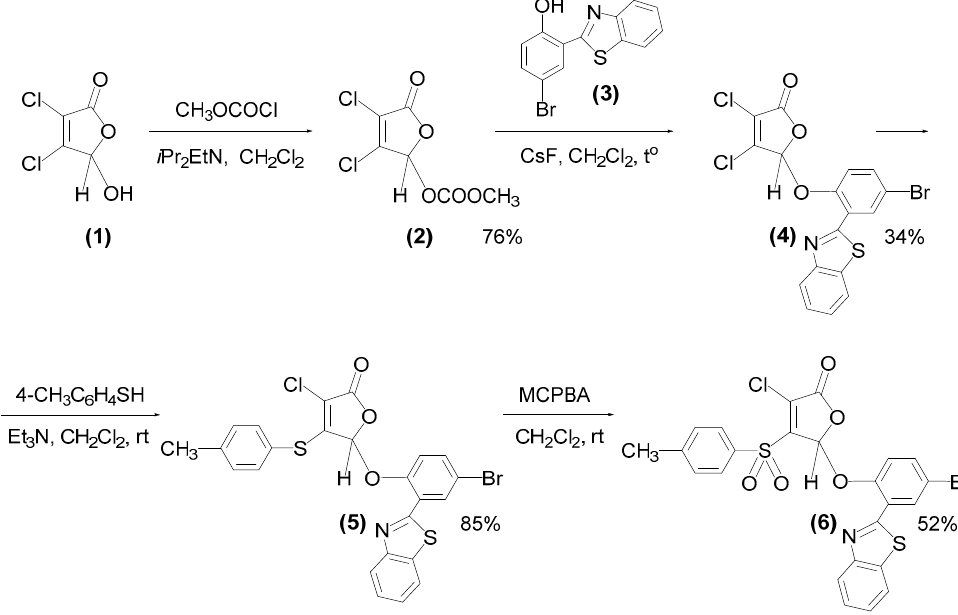
Figure 1. Synthesis of a fluorescent derivative of 2(5 H )-furanone 6 ( F145 ).